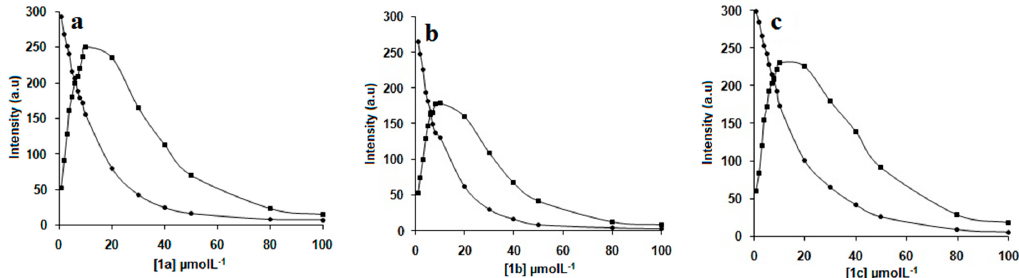
Figure 3. Change in fluorescence intensity of NAP at λ max = 357 ( ● ) and of ( a ) 1a , ( b ) 1b , ( c ) 1c at λ max = 450 nm ( ￭ ) with the concentration of added 1a – c .